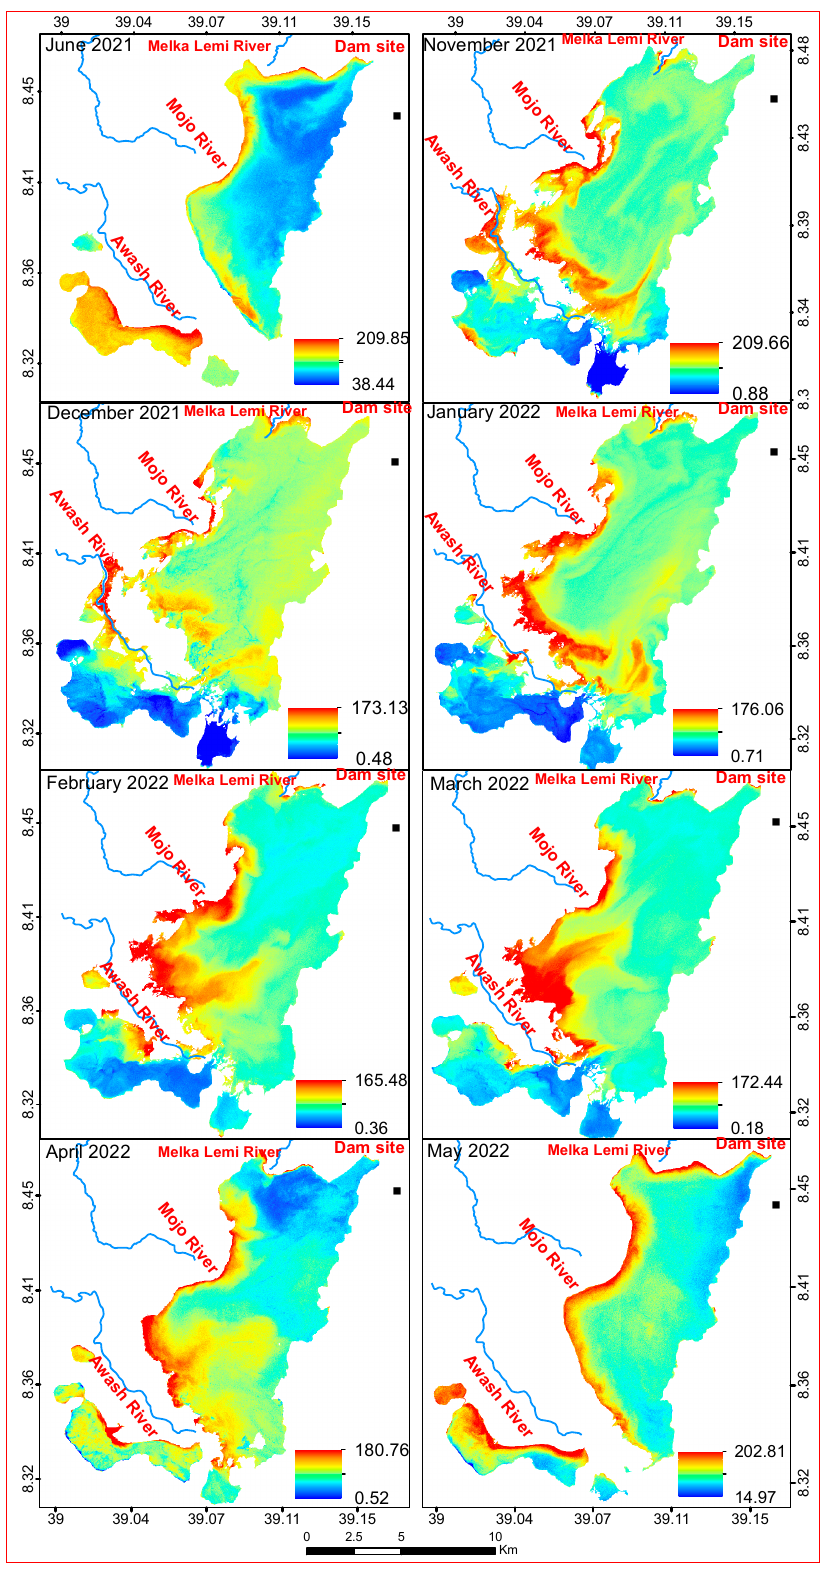
Figure A3. Monthly TU (NTU) spatial distribution.